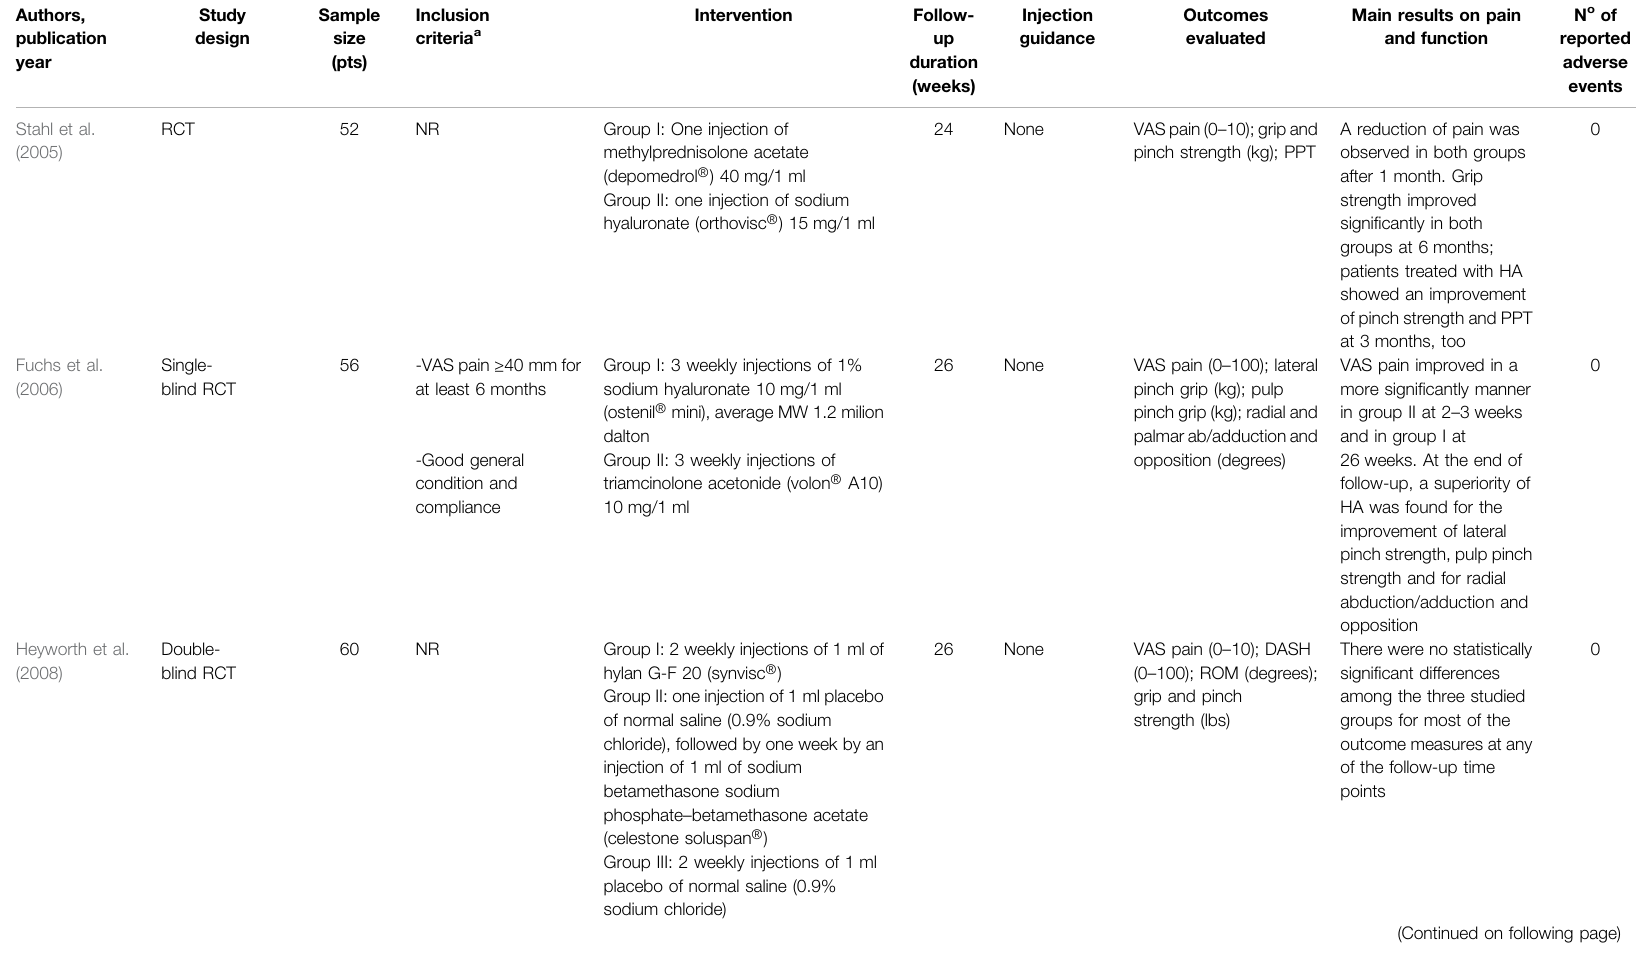
TABLE 2 | Summary of studies investigating intra-articular injections of hyaluronic acid for the treatment of thumb-base